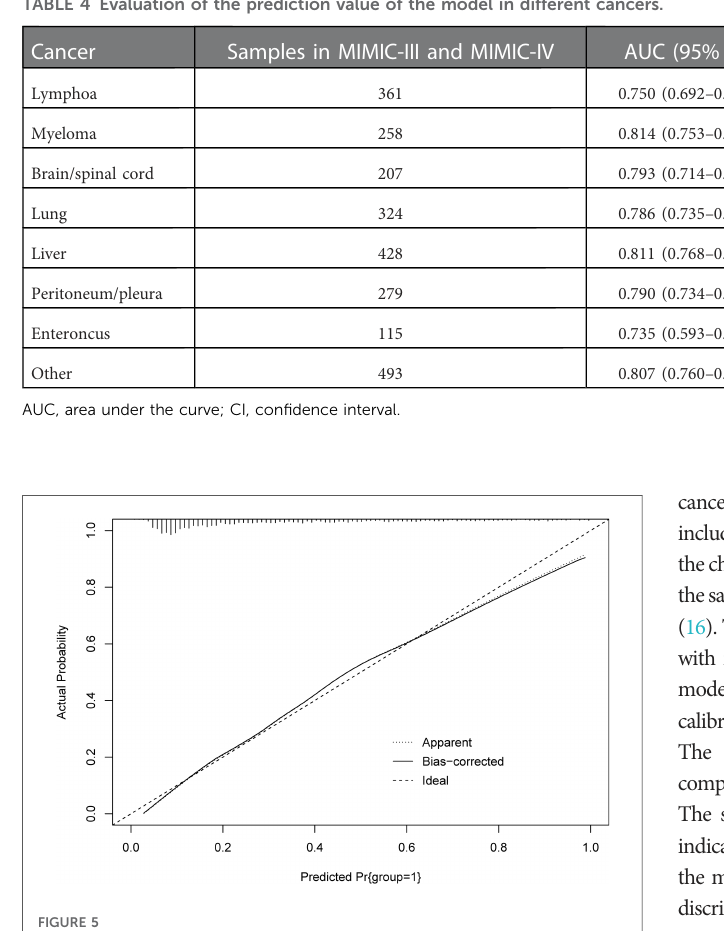
FIGURE 5 The calibration curves of the model in the validation set.